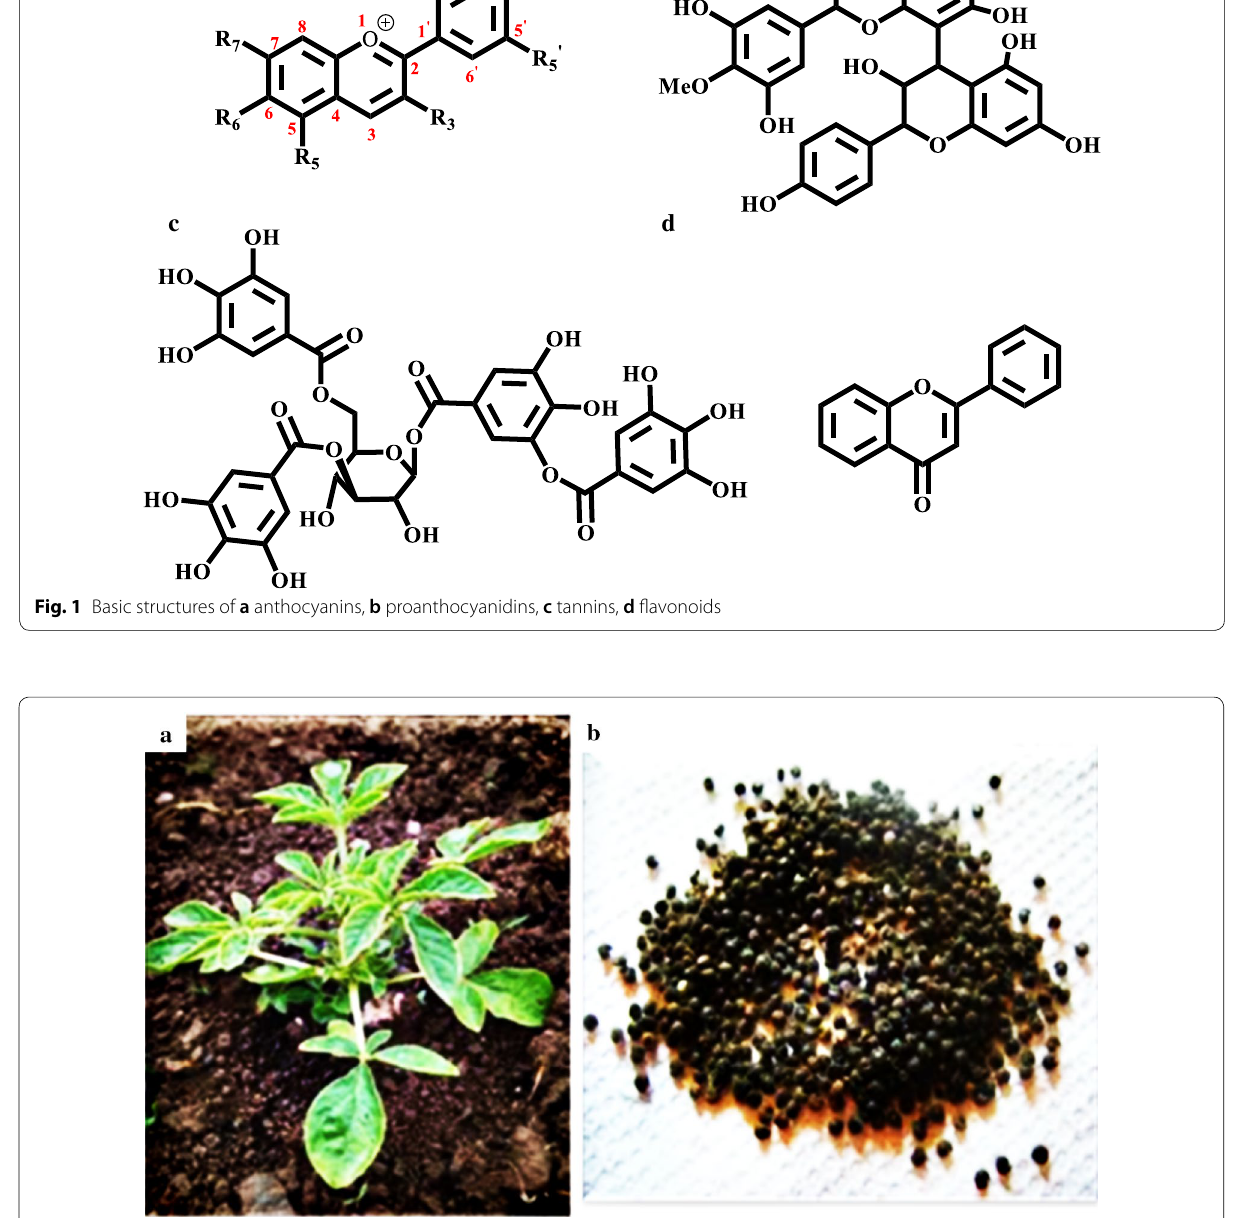
Fig. 2 a Aerial parts and b seed of C.